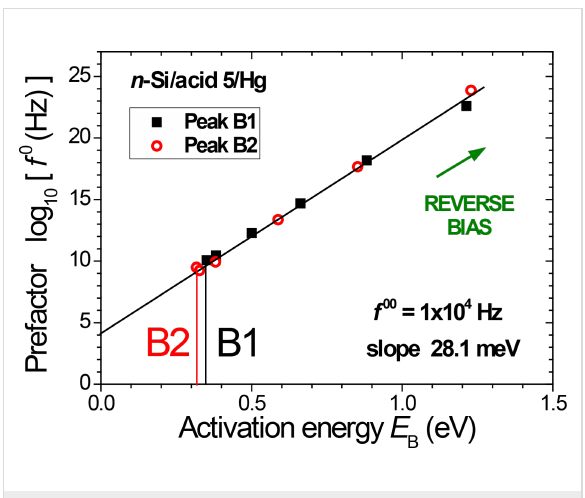
Figure 6: Linear correlation between activation energy and pre-expo- nential factor values derived from Figure 4, for peaks B1 (squares) and B2 (circles). The inverse slope is kT * = 28.1 meV ( T * = 325 K).